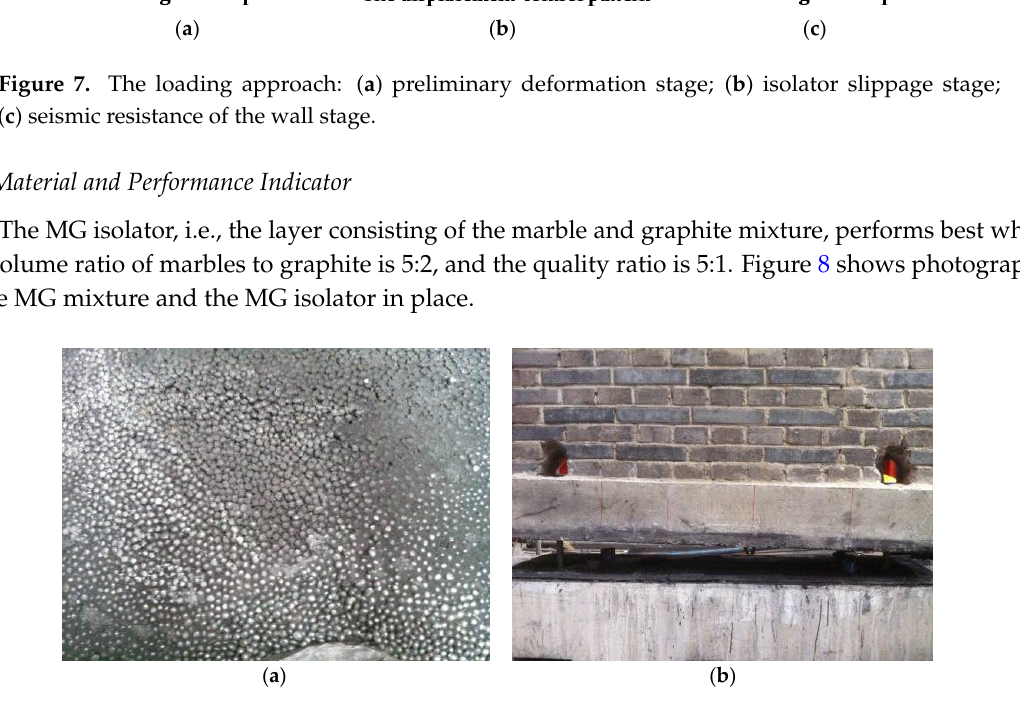
Figure 7. The loading approach: ( a ) preliminary deformation stage; ( b ) isolator slippage stage; ( c ) seismic resistance of the wall stage.